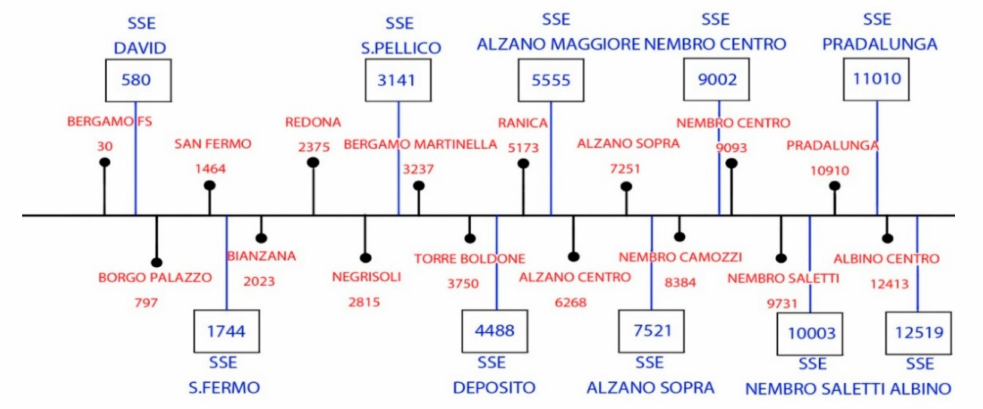
Figure 2. Position of the electrical feeding substations (ESSs) in blue and stops in red along the path (distances from the terminal are indicated in meters).